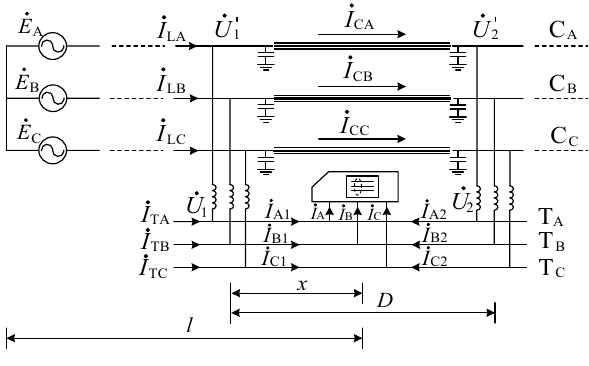
Fig. 4 Equivalent analysis model of three-phase traction